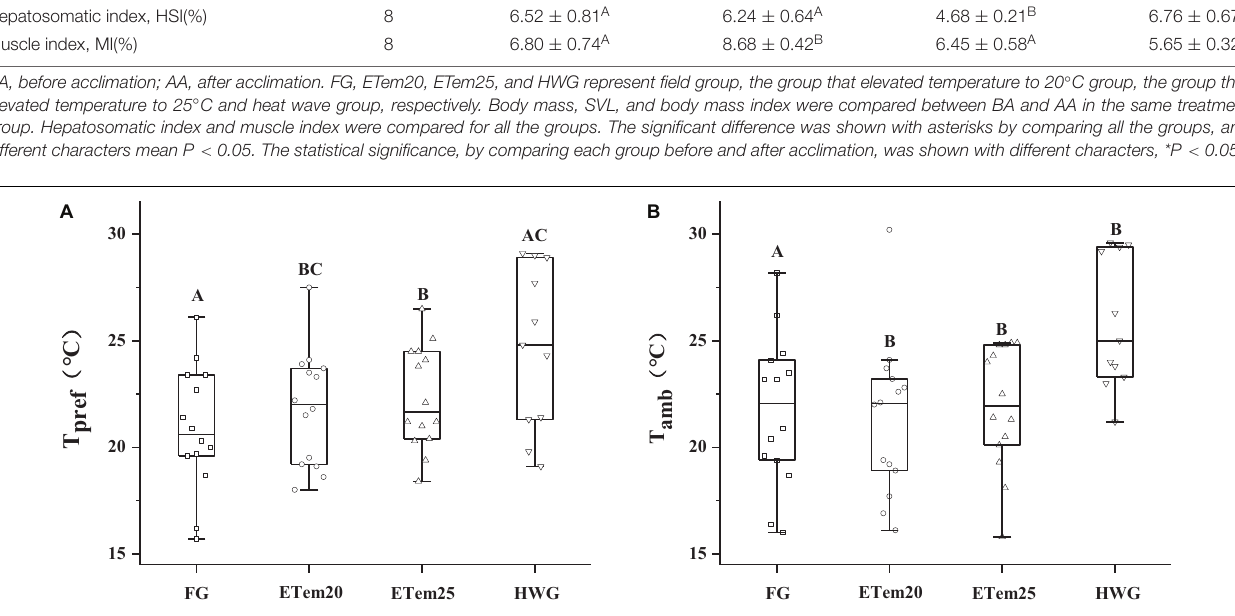
FIGURE 2 | Comparison of (A) thermal preference (T pref ) and (B) ambient temperature (T amb ) of N. pleskei ( n = 13) in different temperature acclimation groups and field group. The line inside the box plot denotes median, the borders of the box depict 25th and 75th quartiles, and the whiskers represent the 5th and 95th percentiles. The dots indicate the outliers and data points. The significant difference was shown by comparing all the groups. Different characters mean P <